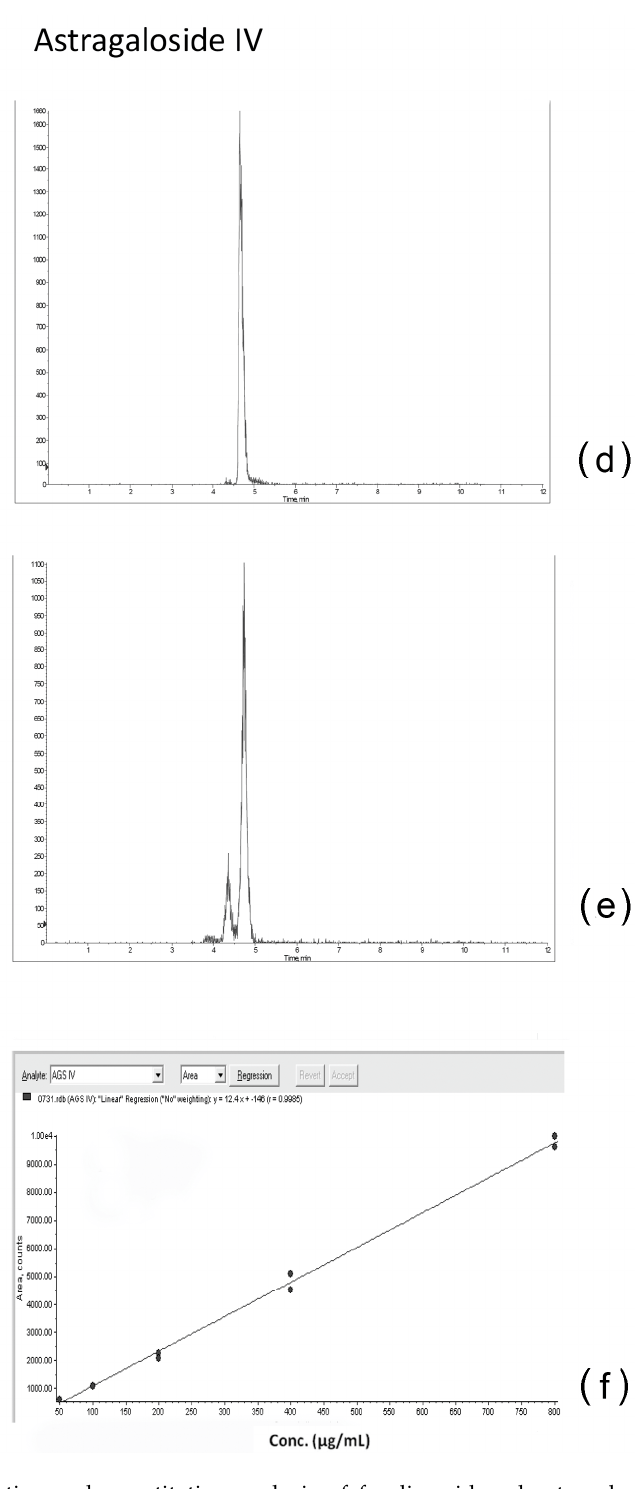
Figure 1. Qualitative and quantitative analysis of ferulic acid and astragaloside IV by HPLC. ( a ) A chromatogram of the ferulic acid standard. Its retention time is 22.7 min; ( b ) A chromatogram of DBT-PD. The retention time of its ferulic acid is 23.1 min; ( c ) Calibration curve (0.05–5 µg/mL) of ferulic acid; ( d ) Multiple reaction monitoring (MRM) mass spectrometric chromatogram of the astragaloside IV standard. Its retention time is 4.75 min; ( e ) MRM chromatogram of astragaloside IV in DBT-PD. Its retention time is 4.76 min; ( f ) Calibration curve (0.5–8 µg/mL) of astragaloside IV. Astragali Radix (AR) and Angelicae Sinensis Radix (ASR) were extracted in boiling water, and DBT was separated into a polysaccharide-enriched (DBT-PE) fraction and a polysaccharide-depleted (DBT-PD) fraction by precipitating with 50% ethanol. Ferulic acid and astragaloside IV are the index components of AR and ASR that were detected by HPLC-UV and HPLC-MS. DBT-PD contained the highest amounts of astragaloside IV (312.626 µg/g) and ferulic acid (1.404 µg/g). 2.2. Osmolality of Culture Medium Containing DBT-PD As shown in Table 2, osmolality of culture medium without DBT-PD was 291.0 ± 5.2 mOsm/kg. Adding ethanol-dissolved DBT-PD cell culture media at a final concentration of less than 15 mg/mL elevated the osmolality to 387.3 ± 14.4 mOsm/kg. Increasing DBT-PD concentration to 30 mg/mL further elevated osmolality to 507.7 ± 18.8 mOsm/kg. To ensure that any inhibition of cell viability was not due to osmolality, the concentration of DBT-PD used in the present study was ≤ 10 mg/mL. The osmolality at this concentration was comparable to that of the media containing ethanol alone (360.0 ± 21.7 versus 375.3 ± 34.1 mOsm/kg, p > 0.05).